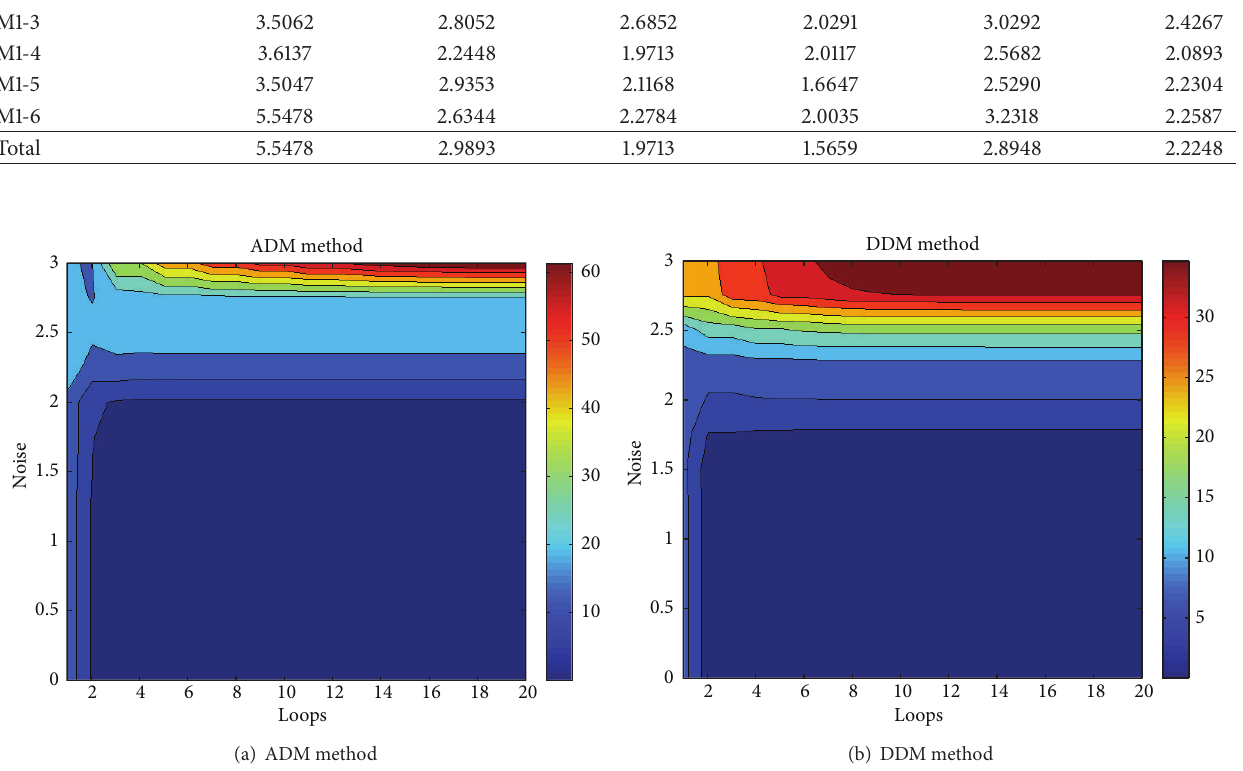
Figure 7: RPE contours with respect to noise level and loops in model 2.